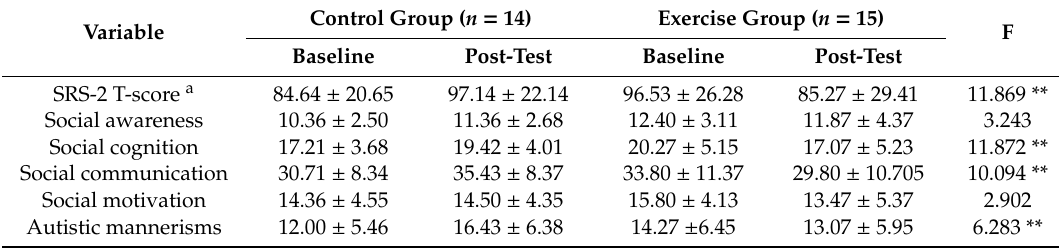
Table 4. Analysis of two groups for social communication variables (mean ± standard